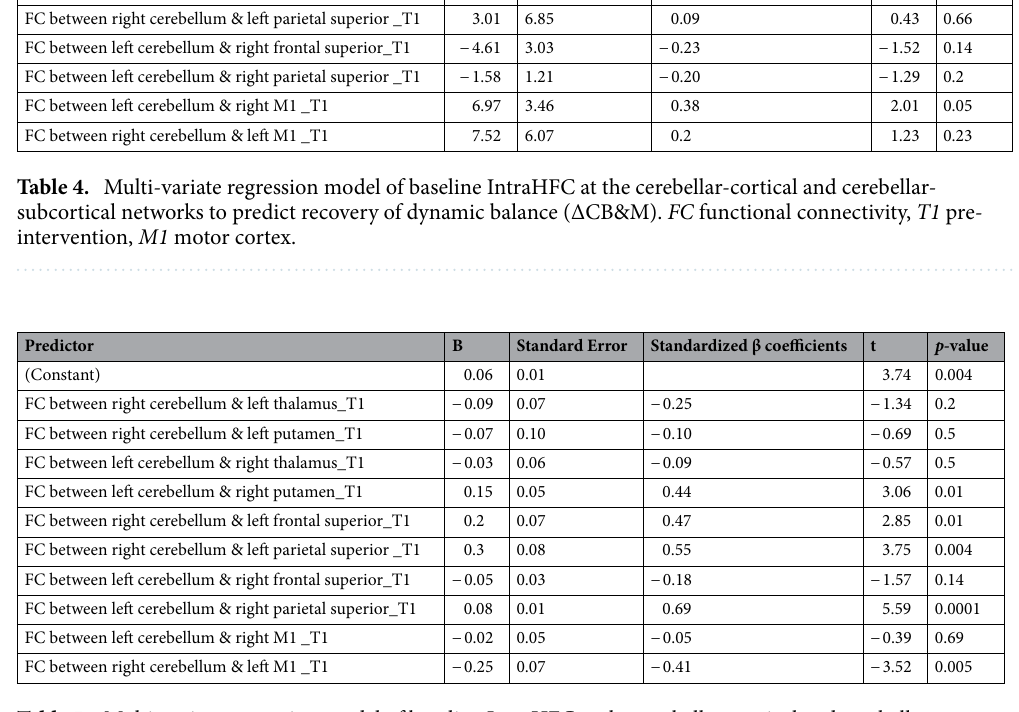
Table 5. Multi-variate regression model of baseline IntraHFC at the cerebellar-cortical and cerebellar- subcortical networks to predict recovery of self-paced velocity (Δ10MWT). FC functional connectivity, T1 pre-intervention, M1 motor